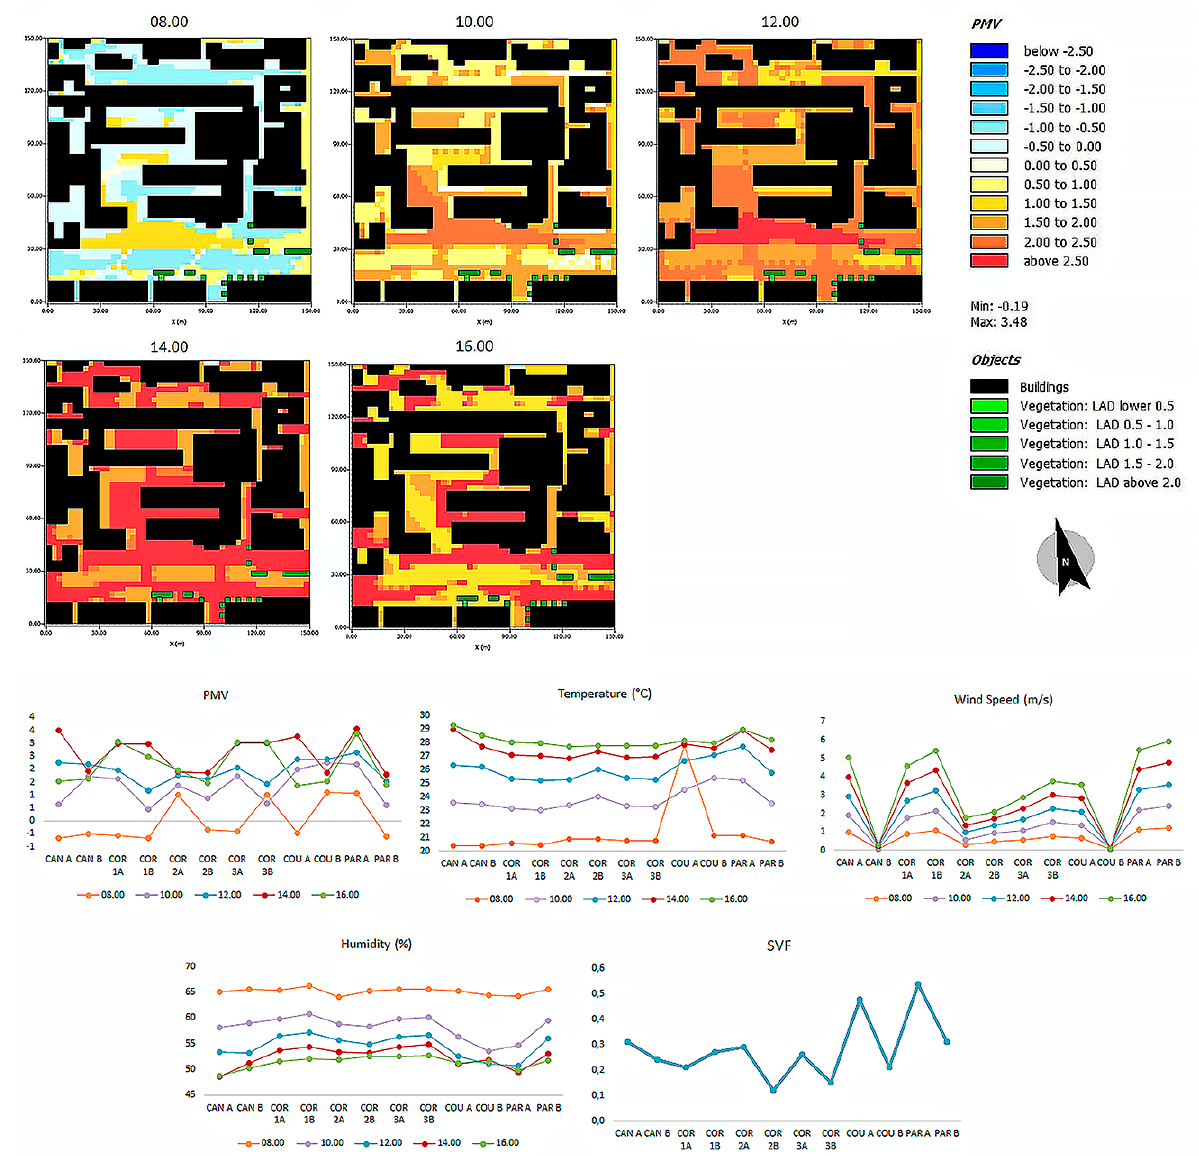
Figure 7 . Simulation result for 5 different time